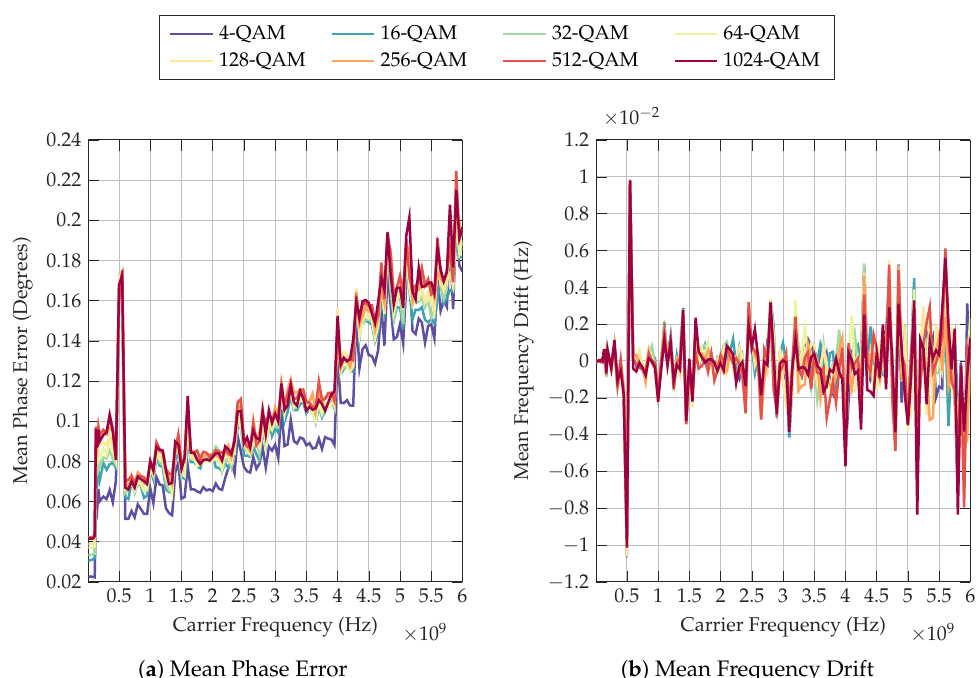
Figure 11. Mean phase error and mean frequency drift as detected by the VST for the 20% SoC